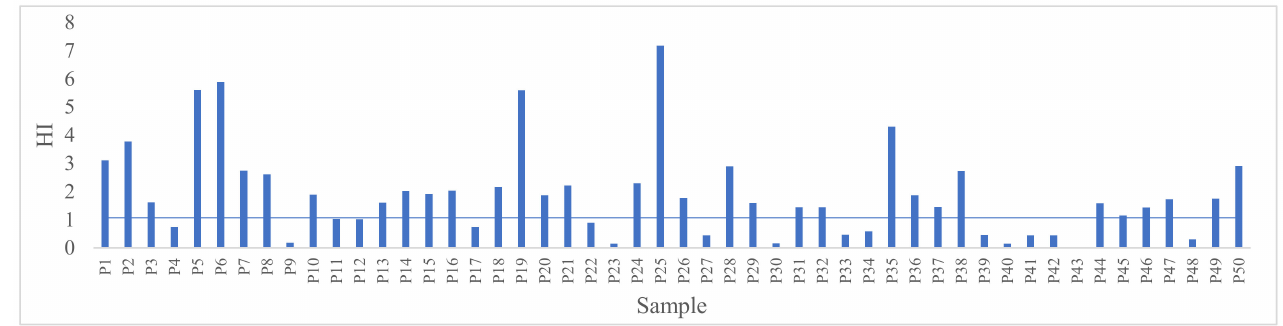
Figure 1. HI values of the tested